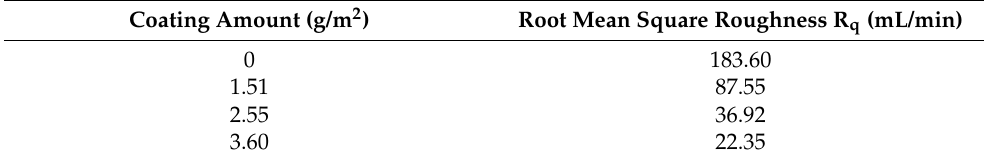
Table 4. Effect of coating amounts on air permeability of packaging base paper.